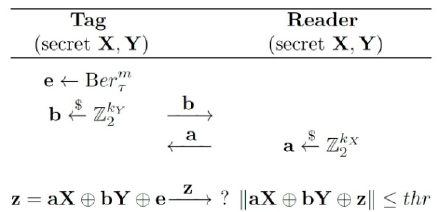
Figure 2. HB# and Random-HB# authentication protocols [13].